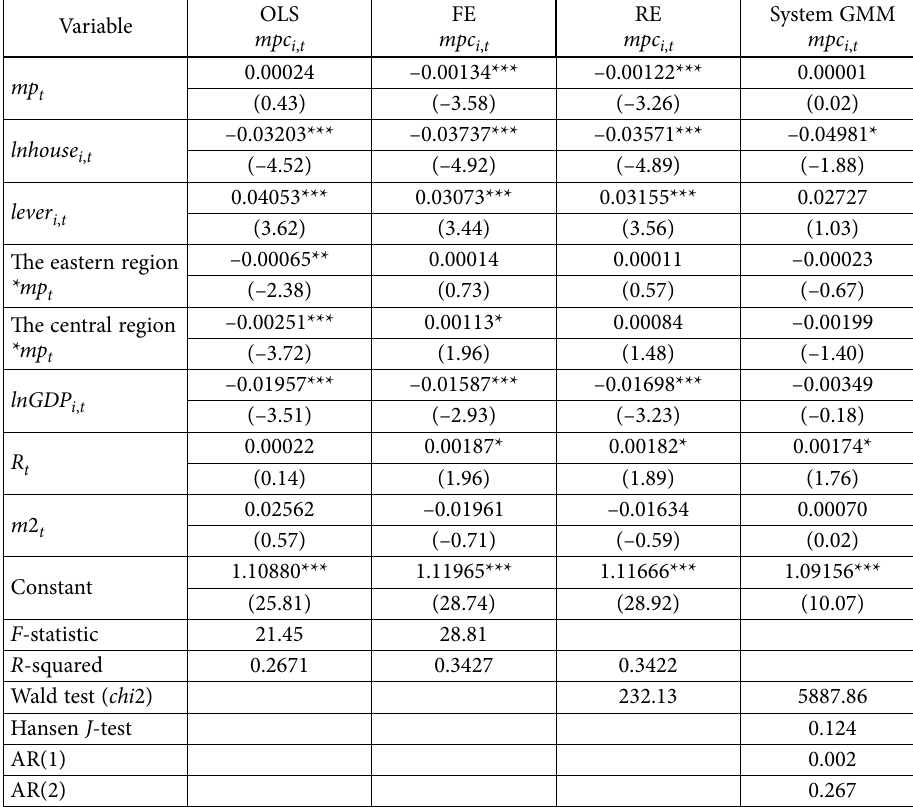
Table 10. The effects of macroprudential policies in different regions